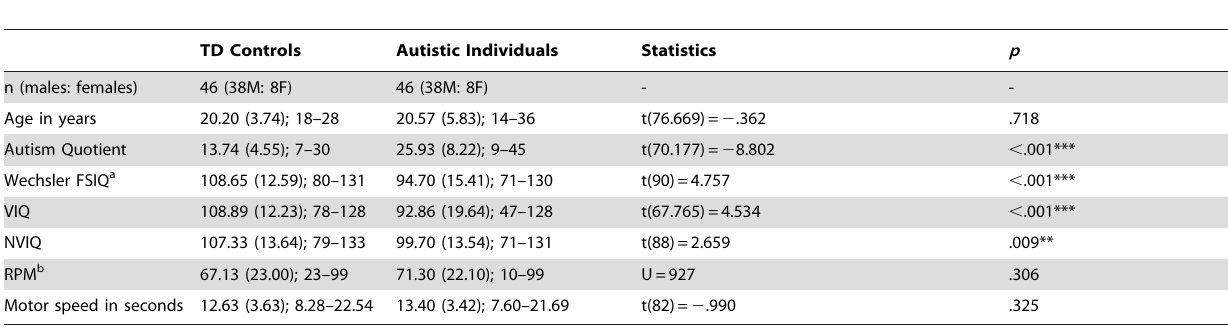
Table 1. Descriptive statistics for all participants including age and Wechsler’s Intelligence Scale IQ (FSIQ, VIQ, NVIQ) and Raven Progressive Matrices (RPM) scores: mean (standard deviation);